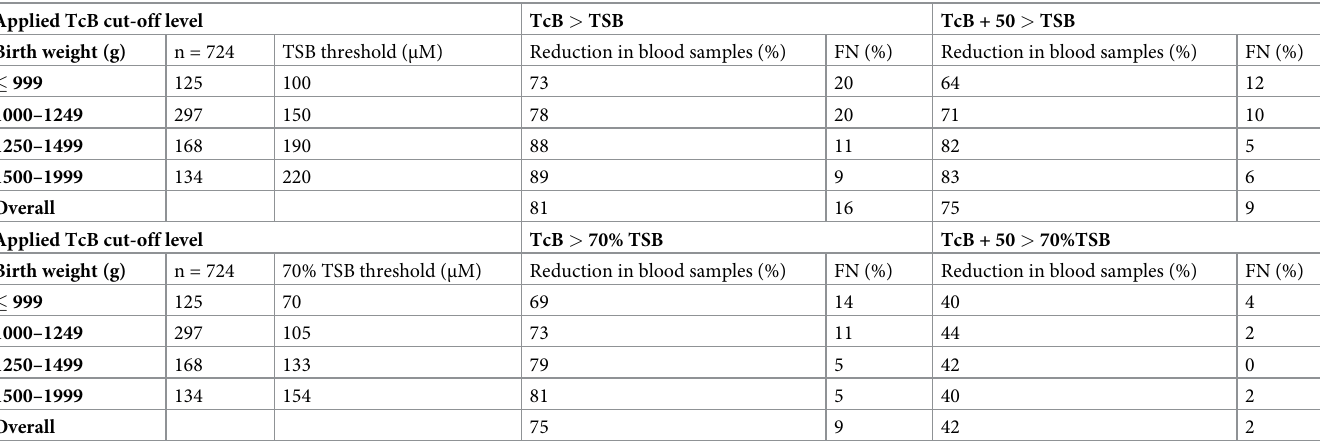
Fig 4. Gestational age categories and the mean difference between TSB and TcB. The y–axis displays the mean difference between TSB and TcB in μ mol/L. TSB, total serum bilirubin in μ mol/L; TcB, transcutaneous bilirubin in μ mol/L; 17.1 μ mol/L = 1 mg/dL bilirubin. The median is marked by the horizontal line in the central box. The boxes are limited by the 25th and 75th percentiles. The whiskers ( ┴ ) represent the minimum and maximum TSB and TcB levels. Outliers ( � ) and extremes (star symbol) are depicted separately. The dashed line is the line at origin. Significant differences between groups are marked in the top of Fig 4 by # ( P < 0.05) or ## ( P < 0.01), respectively. https://doi.org/10.1371/journal.pone.0218131.g004 in line with previous data of TcB during and after PT in fullterm infants. Fonseca and col- leagues described persistent underestimation of TSB by TcB measurements taken on skin exposed to PT, but not on covered skin, whereas Casnoch and colleagues found persistent underestimation after PT on all sites, including the covered lower abdomen (with the lowest Table 2. Effect of different formulas for optimal TcB cut-off levels on blood sample reduction and on false negative percentages per birth weight